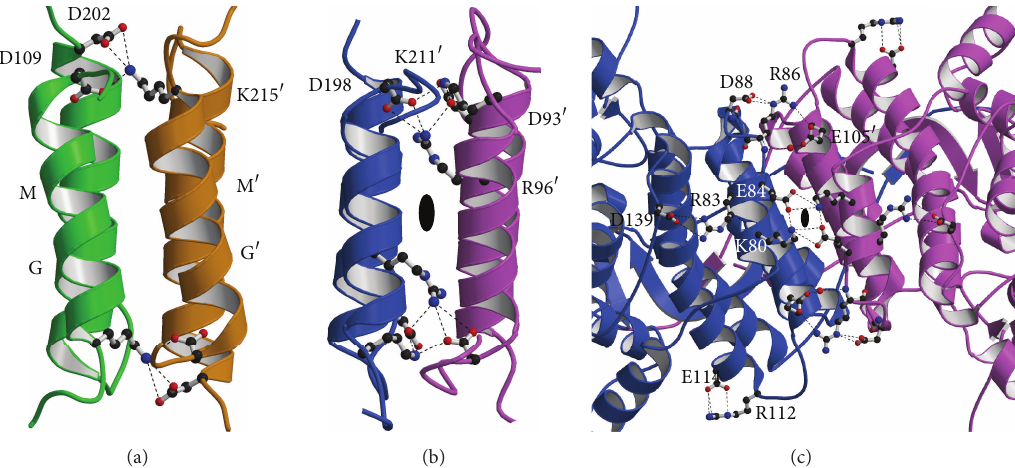
Figure 8: (c) Ion pairs and networks at the molecular surface. (a) Ion pairs near core helices G and M in ST1805-CS. (b) Ion pairs between core helices G and M in ST0587-CS. (c) Extensive ion pair networks found on the surface perpendicular to the axis of the central helix bundle of ST0587-CS. The view is opposite side to that of Figure 2. The residues involved in the ion pairs were drawn as a ball-and-stick model. Polypeptide chains are represented as a ribbon model. Carbon, oxygen, and nitrogen atoms are shown in black, red, and blue, respectively. Hydrogen bonds are indicated as a dotted